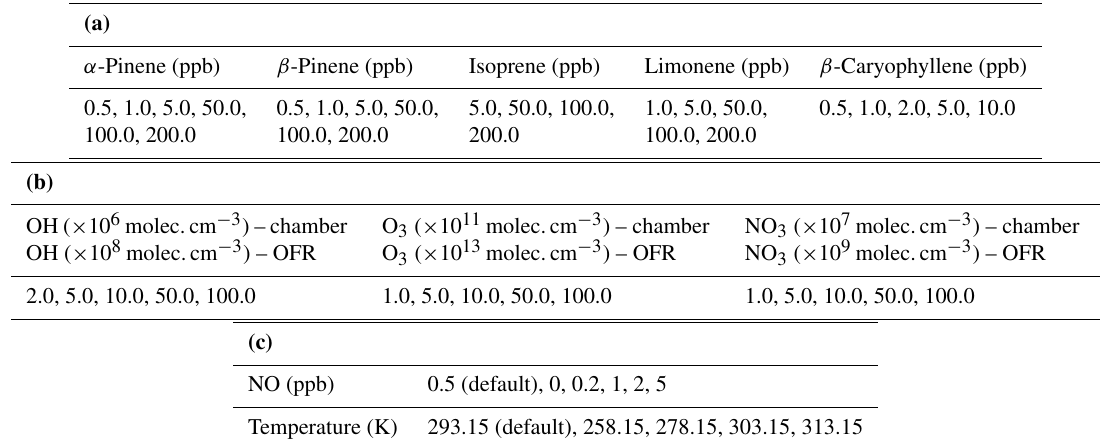
Table 1. (a) Concentrations of different BVOCs. (b) Concentrations of different oxidants for chamber and flow-tube runs. (c) NO concentra- tions and temperatures used for α -pinene